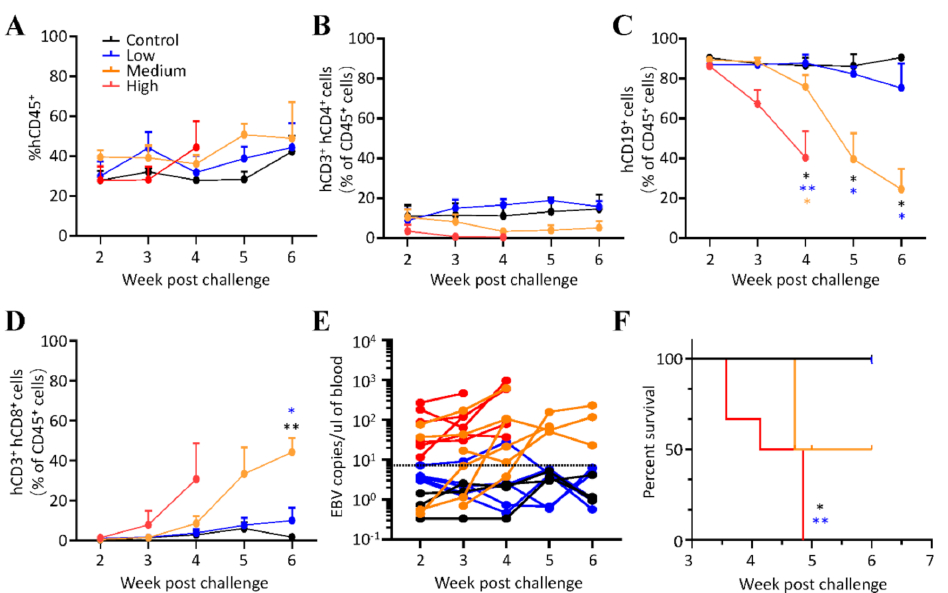
Figure 2. EBV infection in humanized mice. ( A – D ) The frequency of ( A ) hCD45 + , ( B ) hCD3 + hCD4 + , ( C ) hCD19 + , and ( D ) hCD3 + hCD8 + cells in peripheral blood at the indicated time points post-challenge. hCD3 + hCD4 + , hCD19 + , and hCD3 + hCD8 + cells were pre-gated on the mCD45 - hCD45 + human cell population. Data points represent the mean ± SEM of uninfected control mice ( n = 3), low ( n = 5), medium ( n = 6), high ( n = 6) doses (GRUs) of Akata-EBV-GFP infected mice. * p < 0.05, ** p < 0.01 ( E ) Viral DNA was quantified in the peripheral blood of uninfected control mice ( n = 3) and mice that received low ( n = 5), medium ( n = 6), and high ( n = 6) doses (GRUs) of Akata-EBV-GFP. Data are shown as the mean of three biological replicates for each mouse. Each dot represents an individual mouse, and the dotted line indicates the limit of detection. ( F ) Survival of mice was monitored weekly after infection with different infectious doses of the virus (control ( n = 3), low ( n = 5), medium ( n = 6), and high ( n = 6) doses (GRUs) of